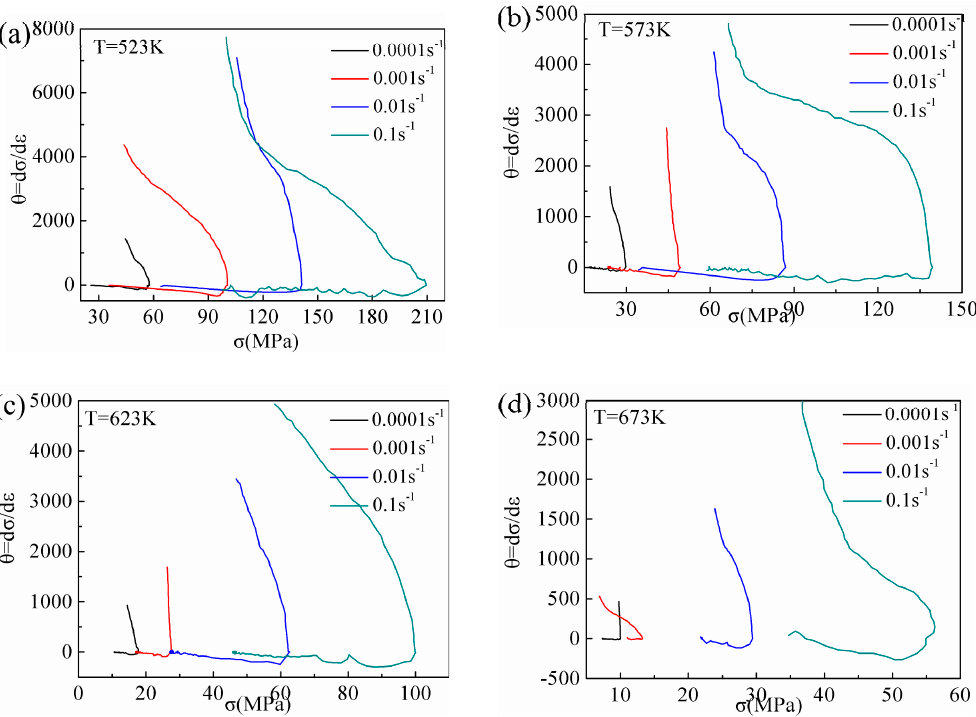
Figure 13. θ - σ curves at different deformation conditions: ( a ) T = 523 K, ( b ) T = 573 K, ( c ) T = 623 K, and ( d ) T = 673 K.